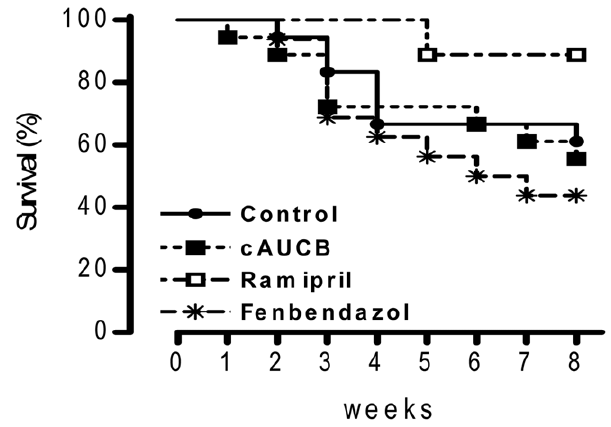
Figure 4. Survival data. Kaplan-Meier survival curves after 5/6-Nx in mice receiving the treatment indicated. n=16, Survial was significantly better only in mice receiving ramipril.